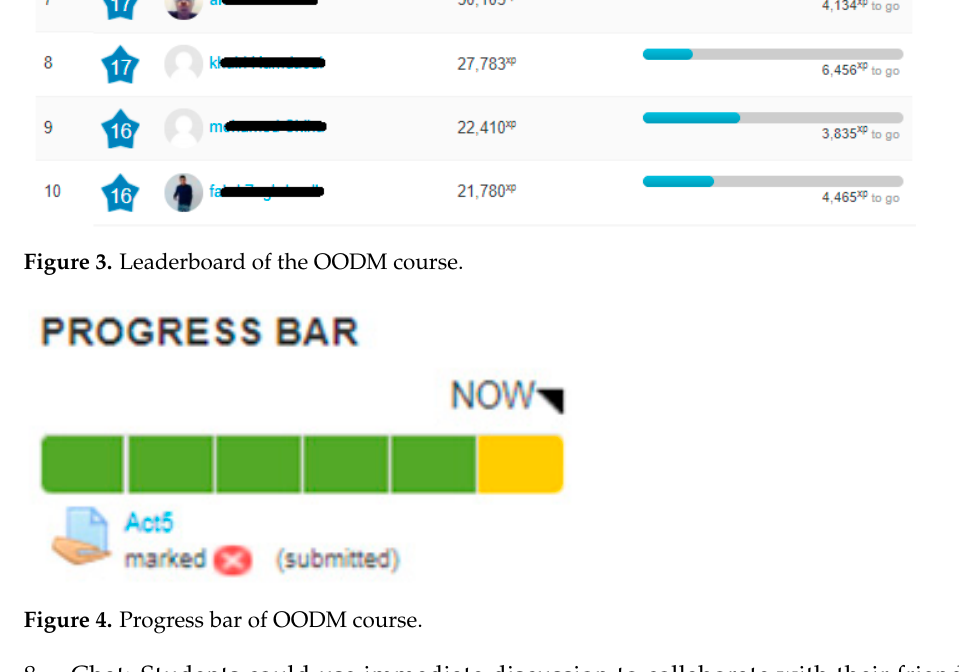
Table 2. Demographic of surveyed students.